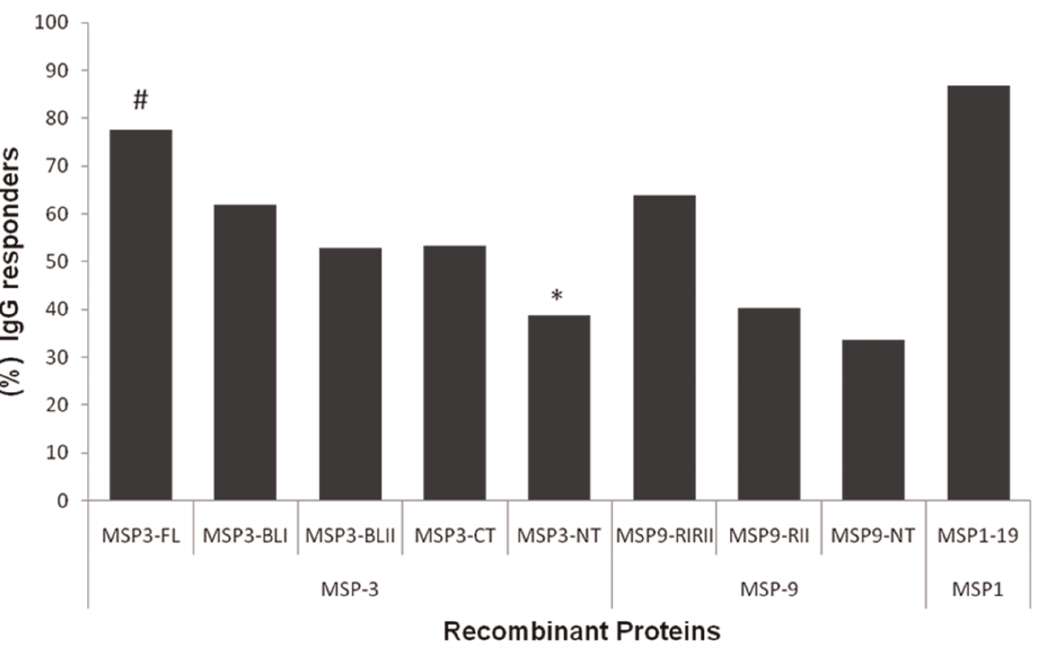
Figure 2. Frequency of IgG responders to PvMSP-1, PvMSP-3 and PvMSP-9. Frequency of IgG responders to five recombinant proteins representing different regions of PvMSP-3 a , three recombinant proteins representing PvMSP-9 and PvMSP-1 19 in the studied population. Chi squared test for proportions analyses were performed to determine statistical differences. # The frequency of IgG responders to PvMSP3-FL was significantly higher when compared with all others PvMSP-3 a recombinants (P , 0.05) * The frequency to PvMSP3-NT was the lowest when compared with all others (P , 0.01), and the frequencies to PvMSP9-RIRII were higher (P , 0,01) when compared with other PvMSP-9 recombinants.